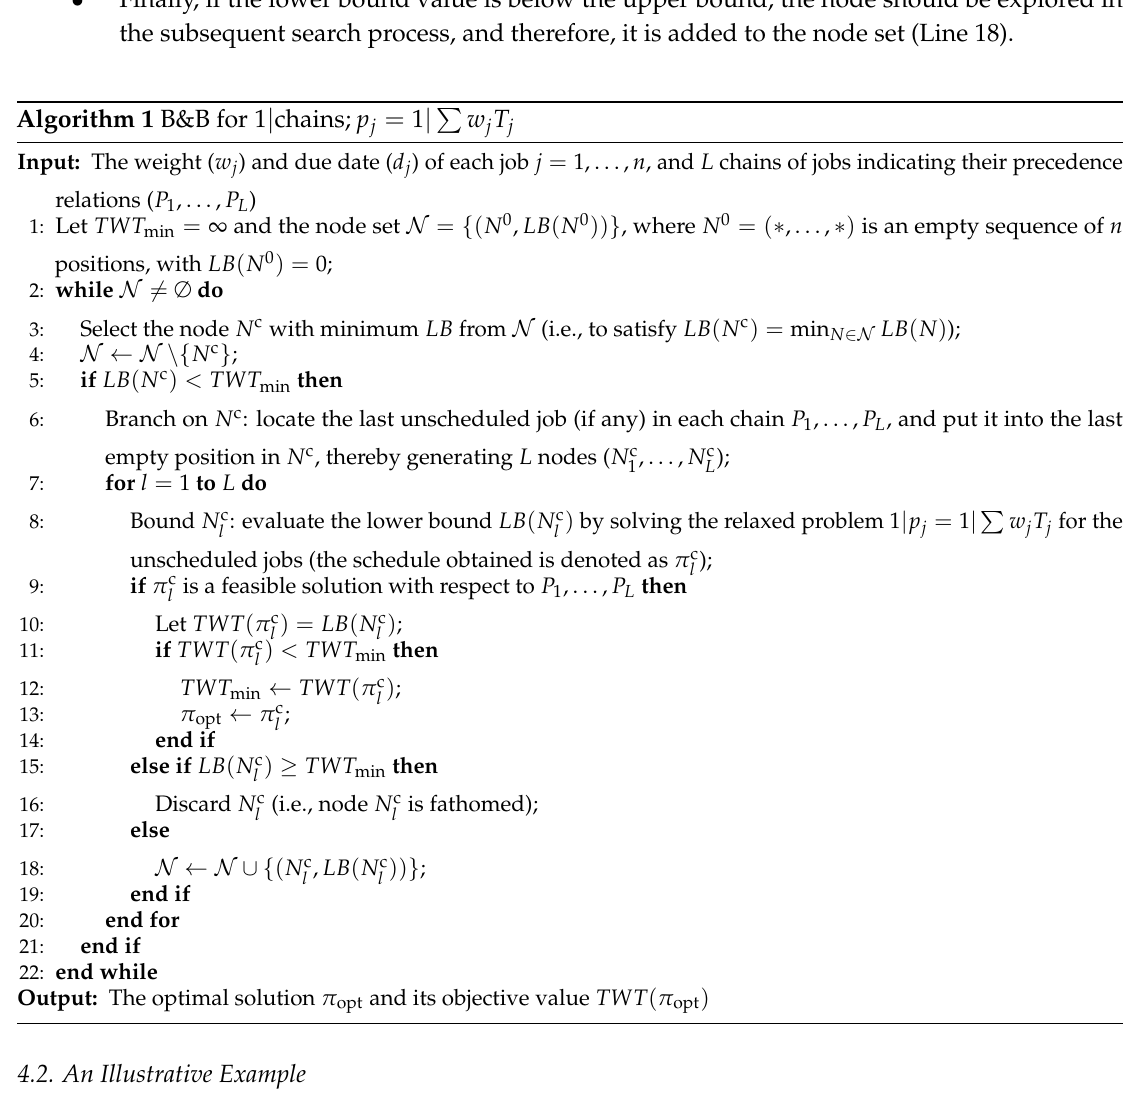
Algorithm 1 B&B for 1 | chains; p j = 1 |